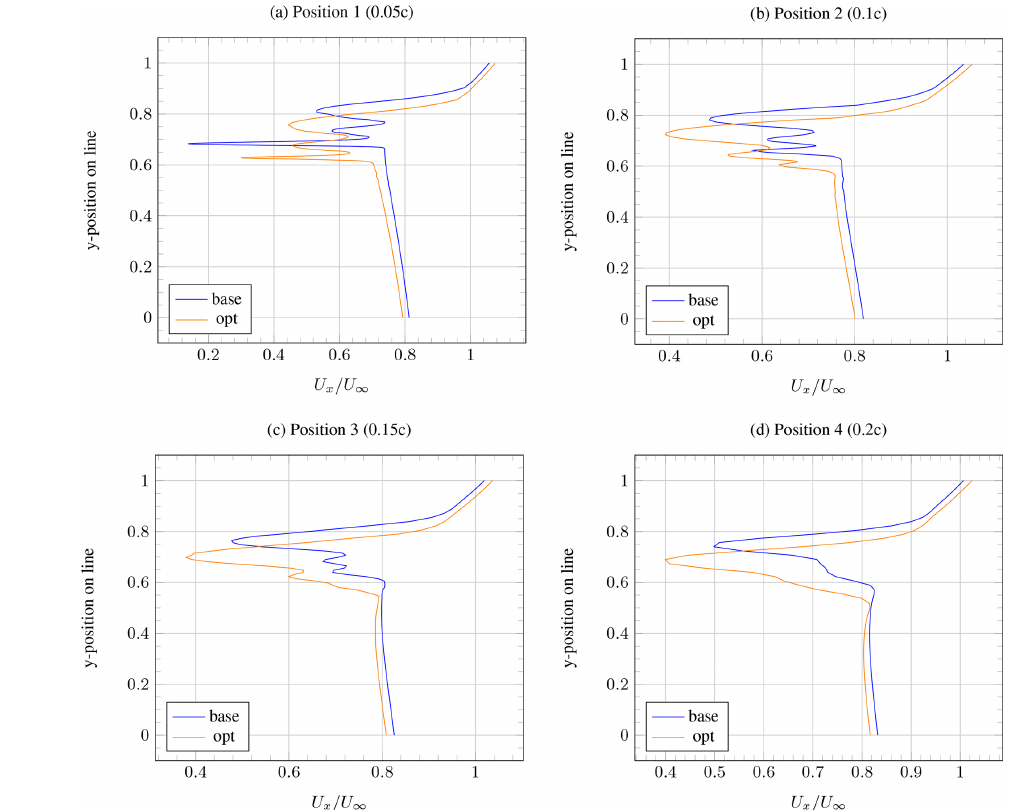
Figure 20. Velocity profile in wake region at (a) Position 1 (0 . 05 c ), (b) Position 2 (0 . 1 c ), (c) Position 3 (0 . 15 c ) and (d) Position 4 (0 . 2 c